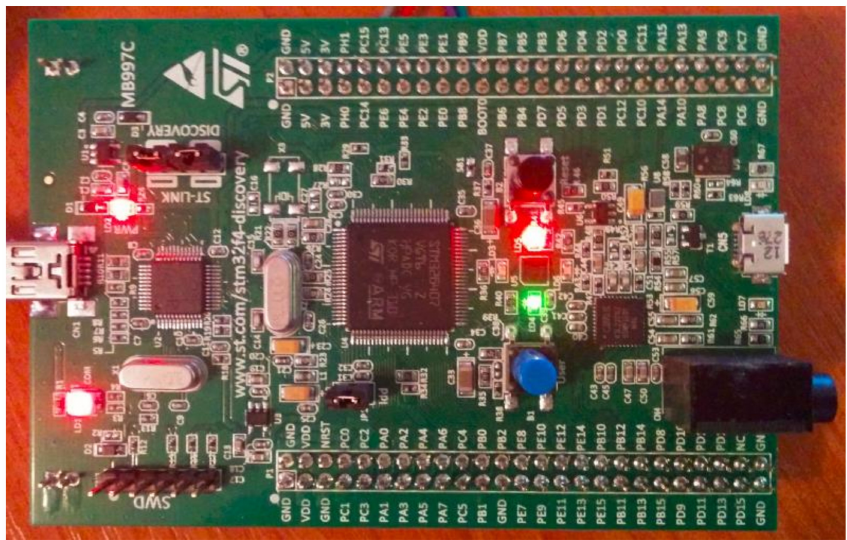
Figure 6. The requests indicated by LEDs on the STM32F4DISCOVERY development board.